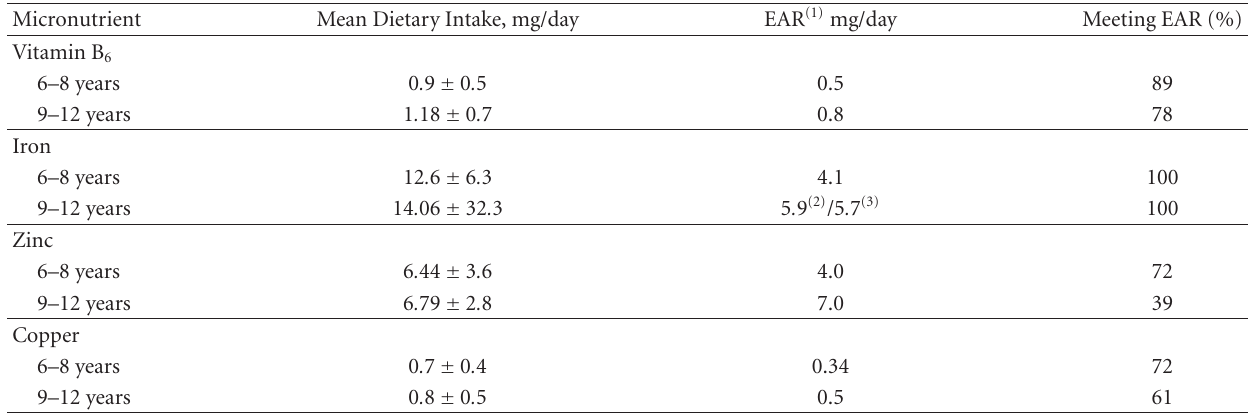
Table 2: Micronutrient intakes of children with ADHD compared to estimated average requirements